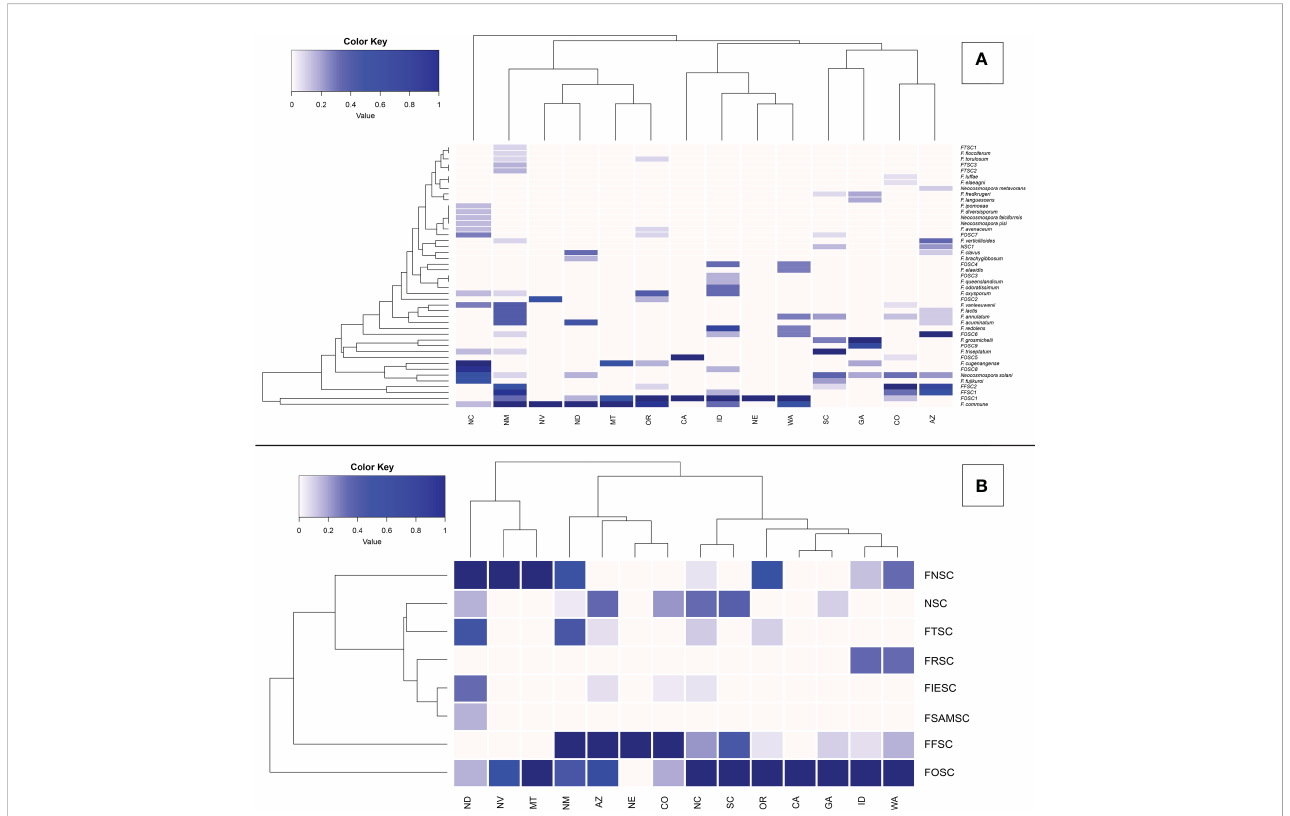
FIGURE 3 Relative abundance of Fusarioid fungi isolates (A) and Fusarioid species complexes (B) collected from conifer seedling host species from 14 states surveyed across the contiguous USA. Abbreviations for species complexes include FNSC - Fusarium nisikadoi species complex; NSC - Neocosmospora species complex; FTSC - Fusarium tricinctum species complex; FRSC - Fusarium redolens species complex; FIESC - Fusarium incarnatum-equiseti species complex; FSAMSC - Fusarium sambucinum species complex; FFSC - Fusarium fujikuroi species complex FOSC - Fusarium oxysporum species complex. Data were normalized to indicate the proportion of Fusarioid fungi isolates collected from each conifer host with mint-cream to green signifying the range of proportion from 0 to 1, respectively. Dendrogram shows the hierarchical relationship between each Fusarioid fungi (y-axis) and host